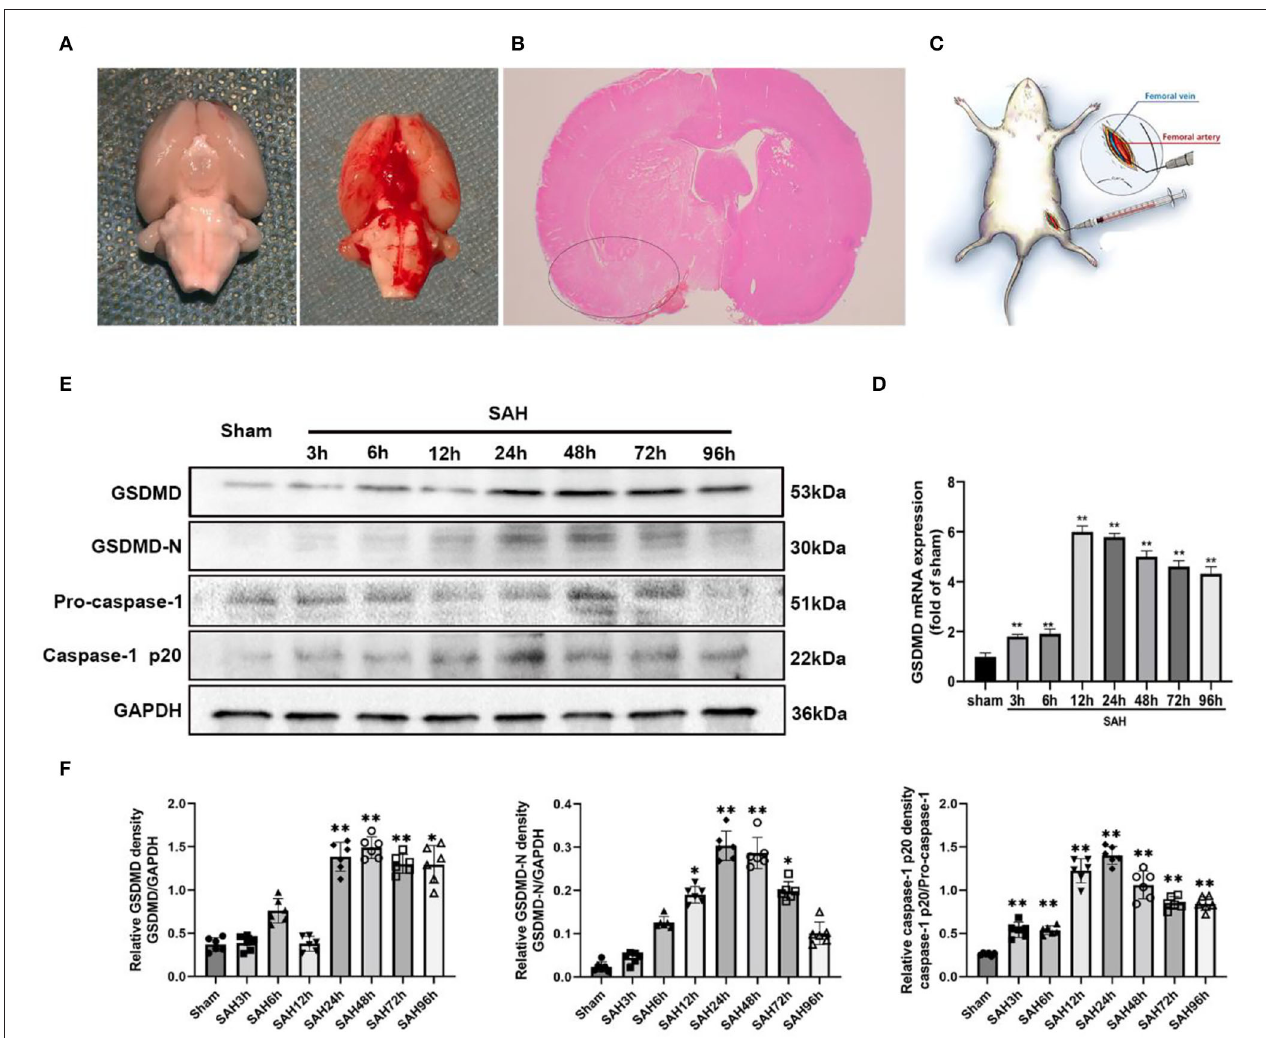
FIGURE 1 | (A) Representative image of subarachnoid hemorrhage (SAH) model. (B) A schematic indicating the brain region for immunochemistry staining, qRT-PCR, IF staining, and western blotting (black circle). (C) Representative image of dexmedetomidine delivery. (D) Quantification of GSDMD mRNA level in rat temporal cortex. (E) Western blot analysis showed the level of GSDMD, GSDMD-N, pro-caspase-1, and Casepase-1 p20 protein abundance at 3, 6, 12, 24, 48, 72, and 96h after SAH. (F) Quantification of GSDMD, GSDMD-N, and casepase-1 p20 protein level as shown in (E) . All values are presented as means ± SD, n = 6 in each time point per group. * p < 0.05, ** p <